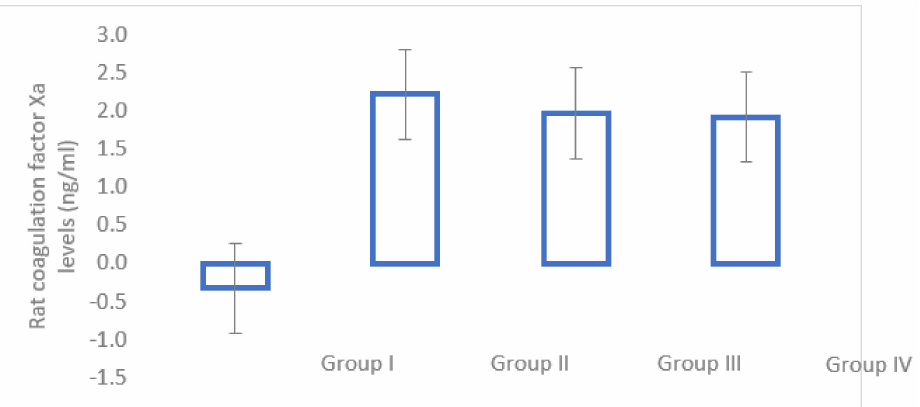
Figure 3. Rat coagulation factor Xa levels at the end of the study in Group I (control), Group II (enoxaparin), Group III (nadroparin) and Group IV (fondaparinux).